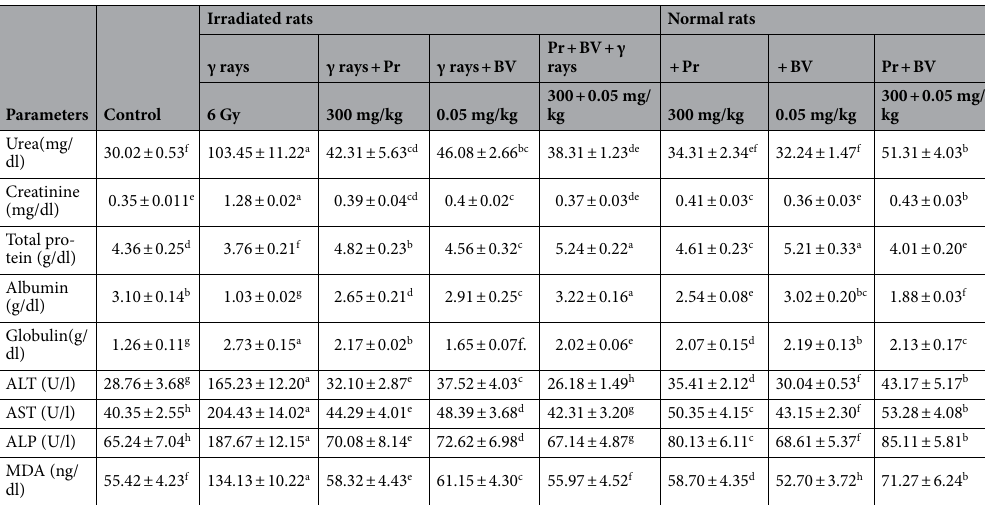
Table 3. Effect of propolis and/or bee venom on liver and kidney functions and plasma lipid peroxidation. Values with same superscript in the same raw are not statistically different. Data expressed as mean ± SE, n = 6. The groups are statistically significant (P < 0.05) as compared with control, using one-way ANOVA followed by Duncan’s test as a post-hoc test.